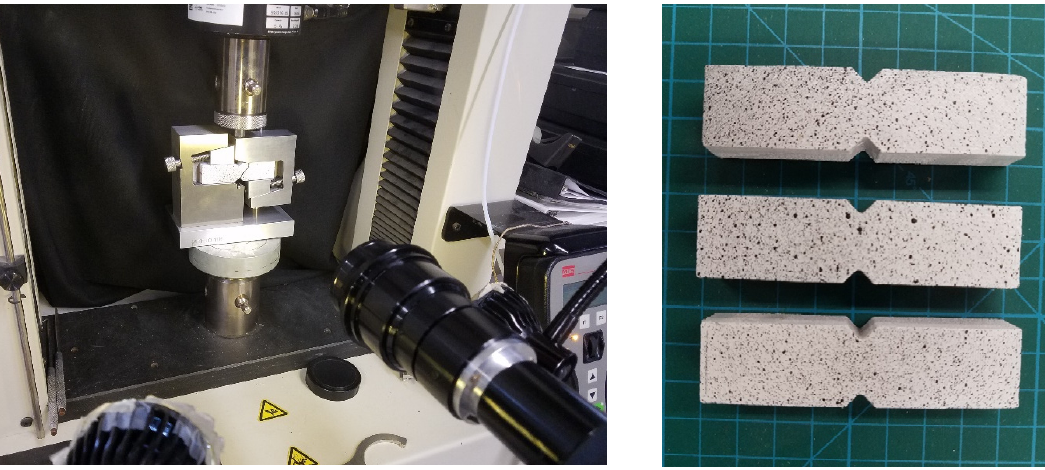
Figure 6. Shear Test Setup after Specimen Failure ( Left ) and Prepped Specimens for Shear Test ( Right